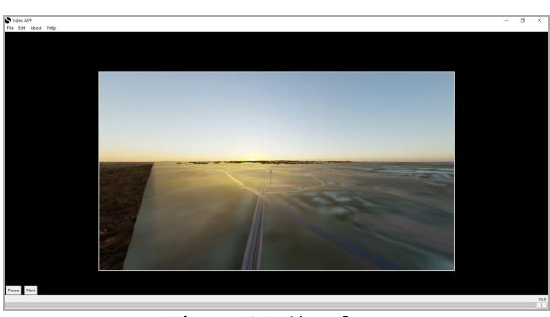
Figure 19 . Video